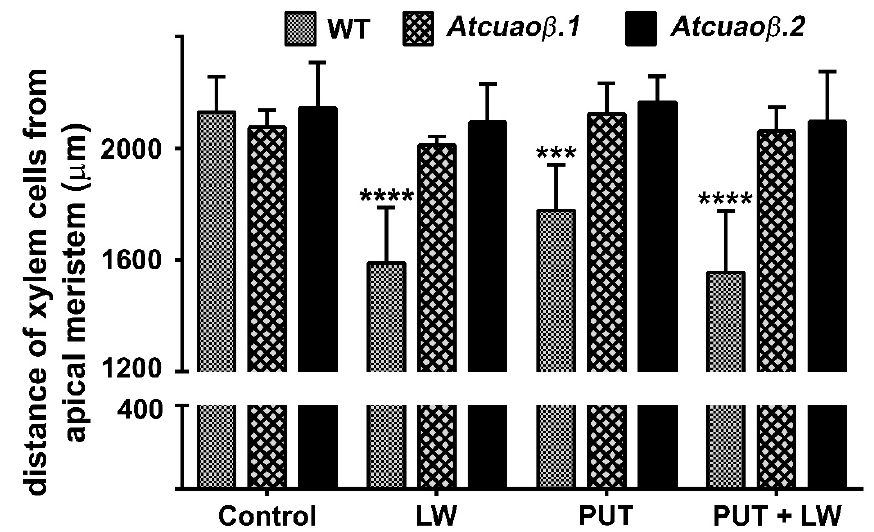
Figure 4. Analysis of di ff erences in protoxylem maturation in 10-day-old leaf-wounded (LW) WT and mutant ( Atcuao β .1 and Atcuao β .2 ) seedlings, grown in medium with or without 100 µ M Put. Distances from the apical meristem of the protoxylem position (defined by the position of the first protoxylem cell with fully developed secondary cell wall thickenings) are reported. These experiments were repeated at least three times with ten seedlings analyzed each time (mean values ± SD; n = 30). The statistical significance levels ( p -values) were evaluated with one-way analysis of variance (ANOVA) followed by Sidak’s multiple comparison test (****, p ≤ 0.0001; ***, p ≤ 0.001). Insignificant di ff erences are not indicated.